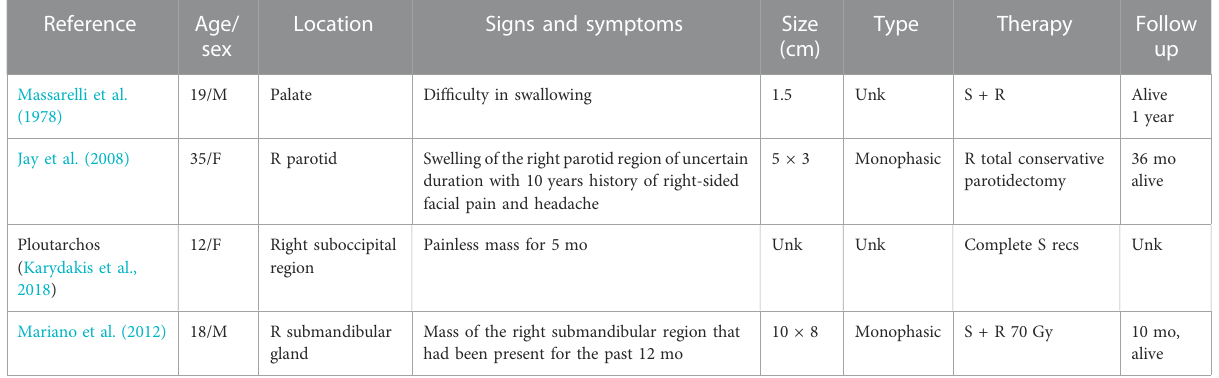
TABLE 5 Report cases of primary synovial sarcoma in other rare sites of the head and neck.